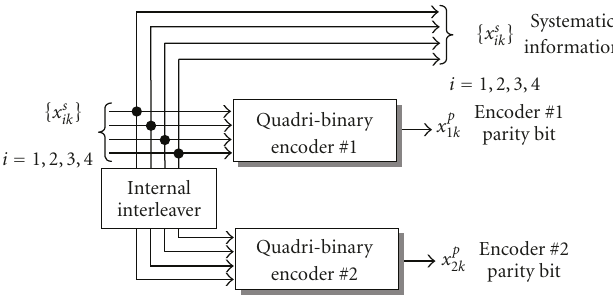
Figure 3: Quadri-binary turbo